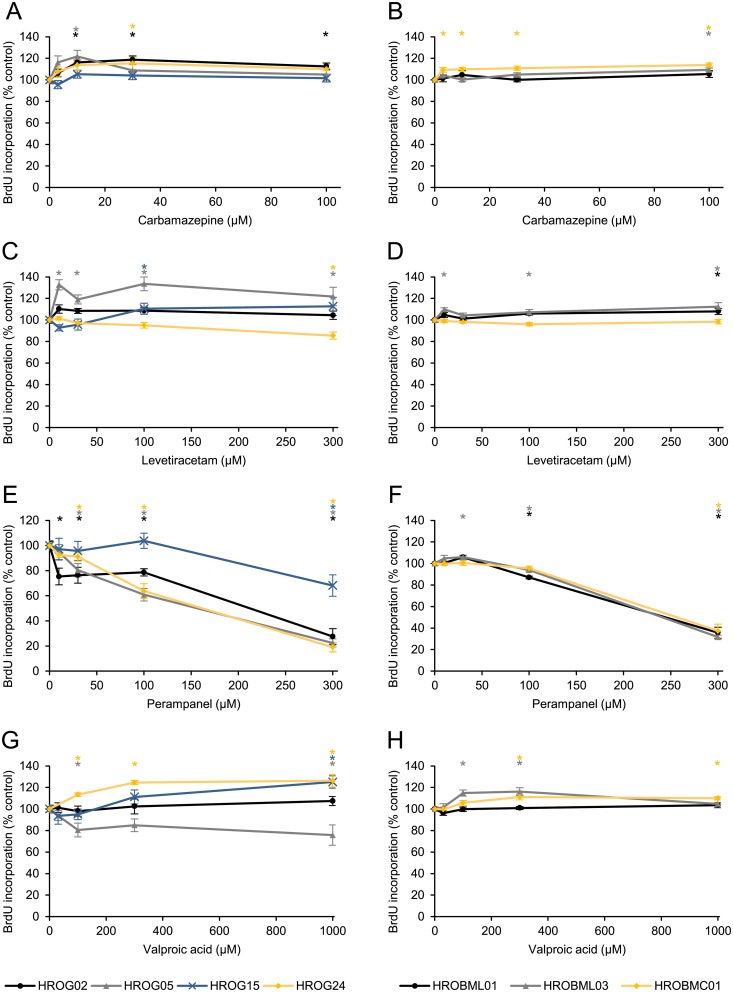
Effects of anticonvulsants on DNA synthesis of glioblastoma and brain metastasis low passage cell lines.Glioblastoma cells (HROG02, HROG05, HROG15, HROG24) and brain metastasis cells (HROBL01, HROBML03 and HROBMC01) growing in 96-well half-area microplates were treated with (A, B) carbamazepine, (C, D) levetiracetam, (E, F) perampanel or (G, H) valproic acid as indicated for 48 h, before DNA synthesis was assessed with the BrdU incorporation assay. One hundred percent BrdU incorporation corresponds to cells cultured without anticonvulsant. Data are presented as mean ± SEM (n ≥ 12 separate cultures); *p<0.05 versus control cultures (Kruskal-Wallis test with post hoc Dunn’s test).